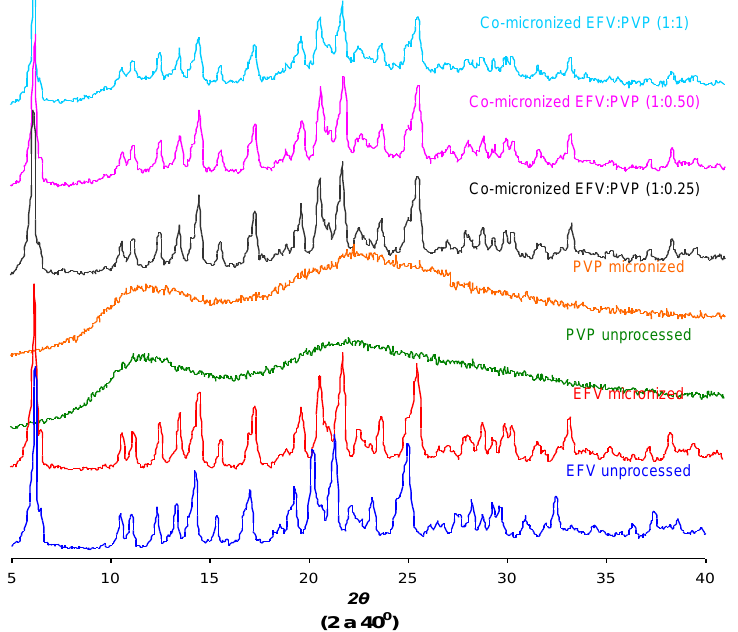
Figure 13. X-ray diffraction patterns of unprocessed and micronized EFV and PVP, compared to co-micronized mixtures of EFV:PVP in the proportions (1:0.25), (1:0.50) and